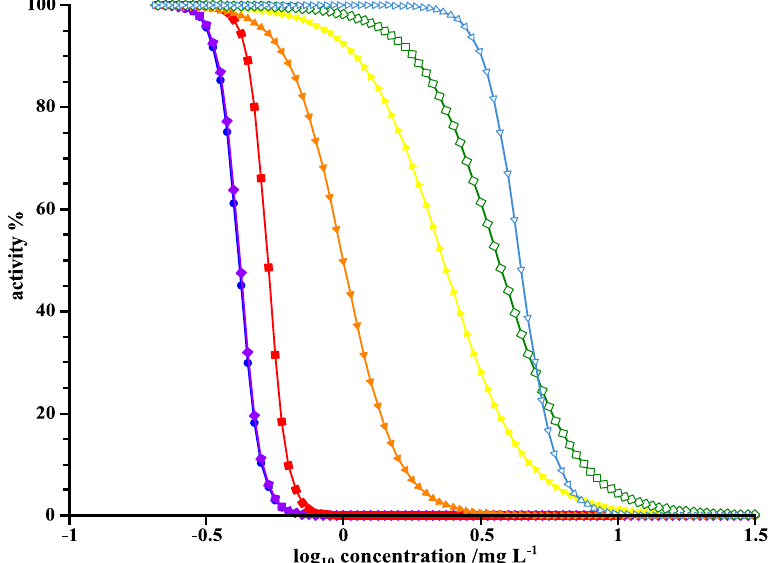
Figure 7. Activity-concentration curves of LOM against P. fluorescens for the determination of IC 50 values at UVA irradiation times of 0 min ( ● ), 1 min ( ♦ ), 2.5 min ( ■ ), 3.5 min ( ▼ ), 5 min ( ▲ ), 7 min ( ◊ ), and 30 min ( ∇ ).